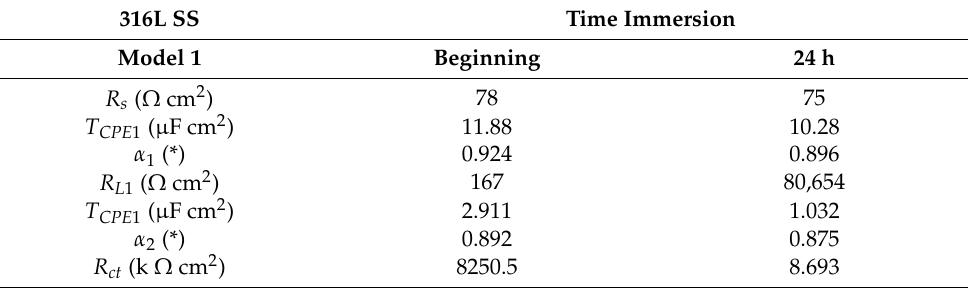
Table 8. EIS Parameters obtained by substrate experimental data fitting (Model 1, Figure 19).